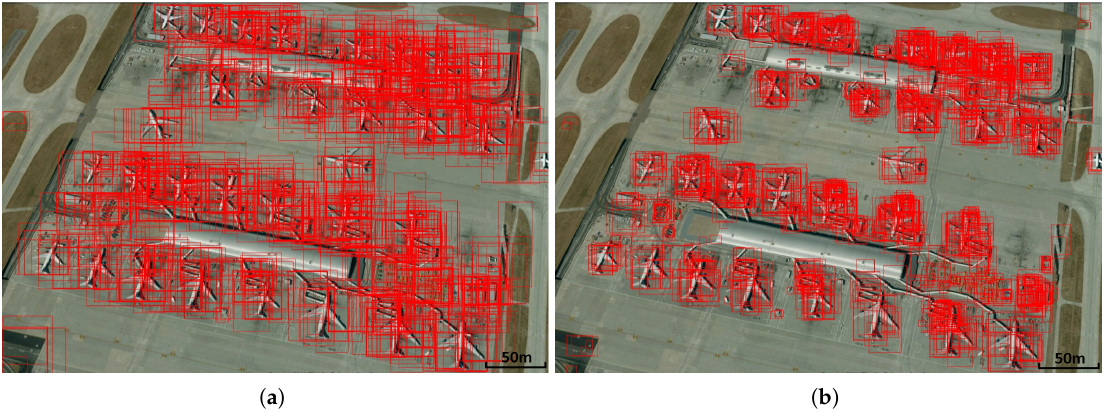
Figure 8. Display of the result that the detection agent generated on one test image which has 1296 × 883 pixels. All boxes are located with red bounding boxes. ( a ) an example of the candidate boxes generated by the restricted EdgeBoxes on the test image; and ( b ) the result the detection agent generated, and the bounding boxes converge on the